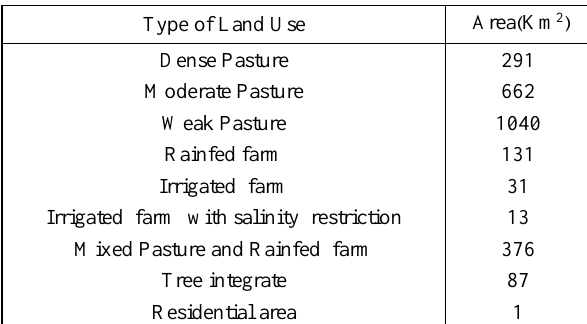
Figure 2. Flowchart for estimating runoff (figure 3) was extracted with 93% overall accuracy. Table 3 shows the type and the area of different land use of Zilberchai basin. The most of the Zilberchai basin area is weak pasture that this kind of land use has poor hydrological condition and low infiltration.